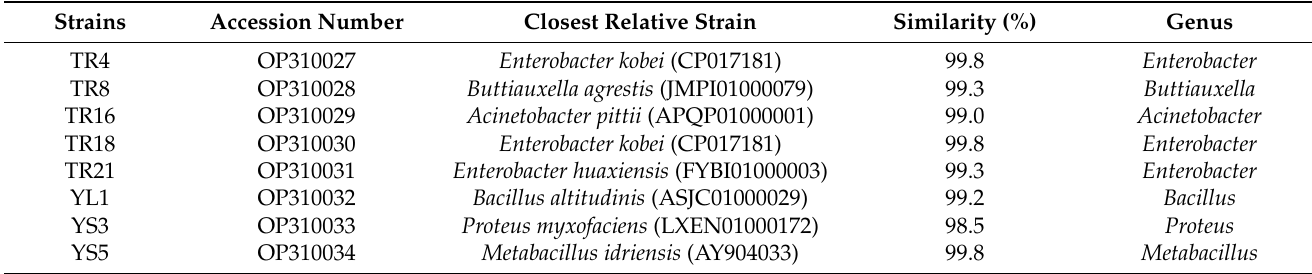
Table 4. The 16S rDNA gene sequence similarity analysis of the eight